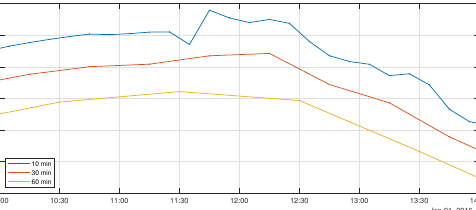
Figure 9. Same irradiance measurement averaged with a 10/30/60-min window. The plots have been offset for better readability.